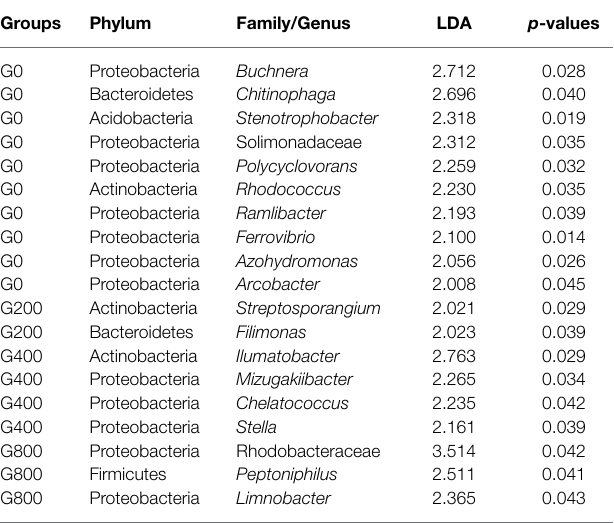
TABLE 8 | Linear discriminant analysis effect size (Lefse) of indicator bacteria species that were significantly ( p < 0.05) associated with each group. Groups